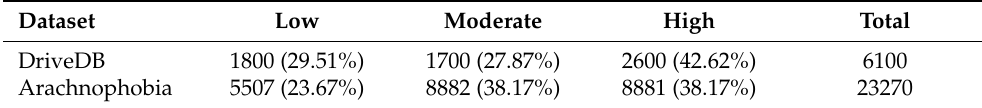
Table 3. Number of samples per dataset, using a window size of 3 s.